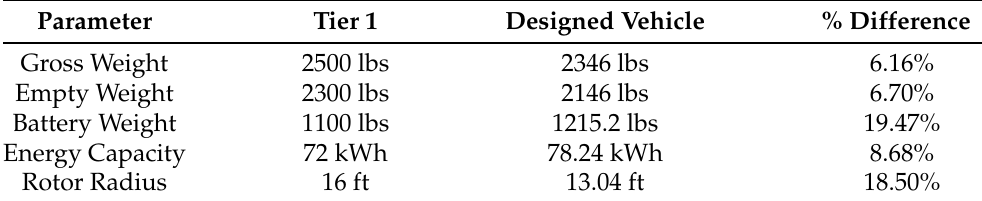
Table 4. Comparison of Tier 1 [28] test aircraft to that designed using the current